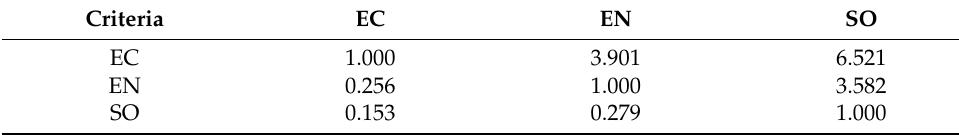
Table 9. Crisp matrix for CR.